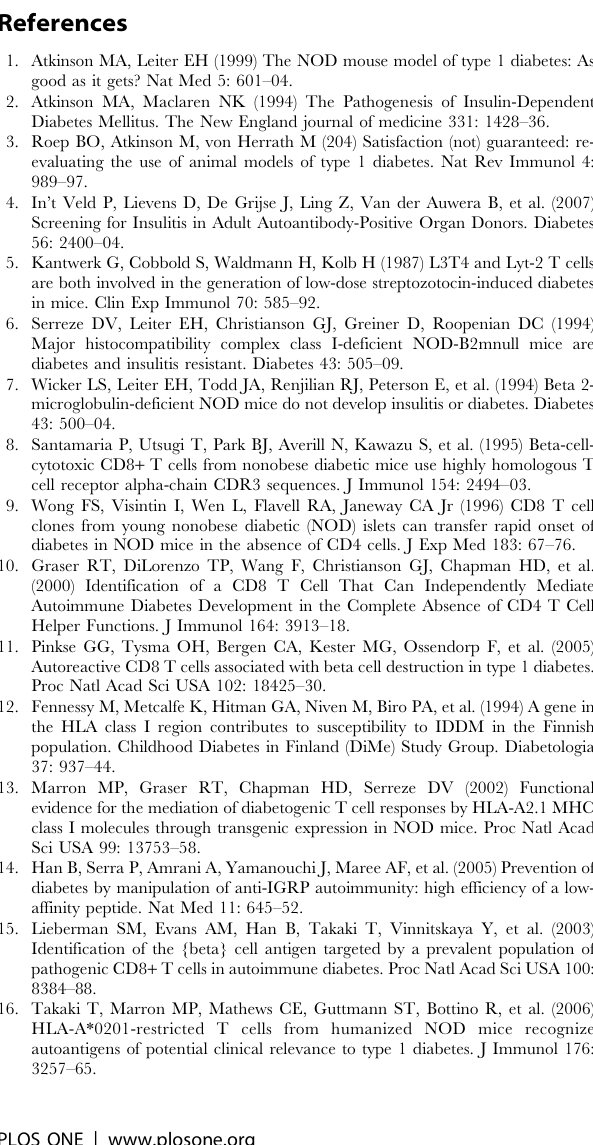
represent isotype antibody staining, solid lines represent specific antibody staining. These results are representation of 3 experi- ments. Table S1 Clone 7 IGRP/A2 binding T-cells cloned from a type 1 diabetic individual are clonal. Clonality of IGRP- specific clone 7 T-cells was determined by examining expression of TCR V a and TCR V b chains. Specific PCR with C a or Cß reverse primer in combination with a specific forward primer for V a or Vß TCR revealed expression of V b 13c and V a 19 transcripts in clone 7 T-cells. Control PCR amplifications for b - actin were performed for each sample to confirm cDNA integrity. Total RNA was isolated using RNA BEE (Tel-Test, Friendswood, TX). Random-primed cDNA was synthesized according to manufacturer’s instructions (Roche, Indianapolis, IN). PCR amplification of cDNA was performed with C a or Cß